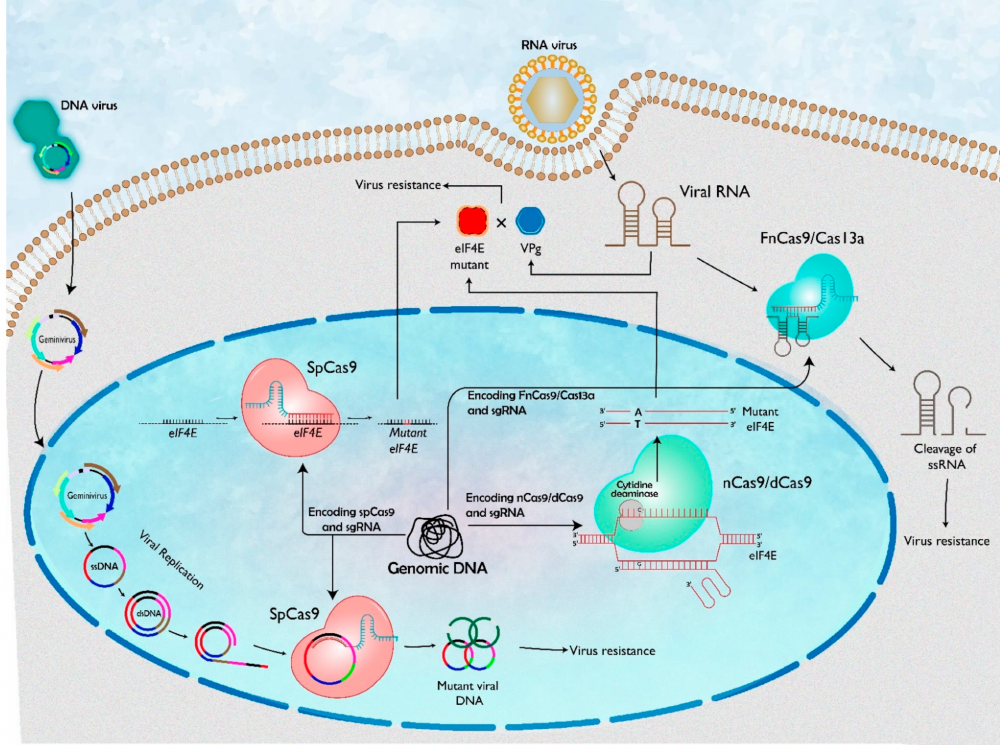
Figure 1. Representation of CRISPR/Cas systems to confer resistance against DNA and RNA virus. On entering plant cells, the viral genome is transcribed and translated using host factors. Subsequently, the viral genome is multiplied and spread to other cells. The viral genome can be targeted by the CRISPR system using Cas9/nCas9/dCas9/FnCas9/Cas13a as endonuclease. Components of the CRISPR/Cas9 machinery, sgRNA and Cas9 are expressed from the plant genome and form sgRNA- Cas9 complex. Upon viral infection, the viral DNA replicates through the dsDNA replicative form inside the nucleus of the host cell. The sgRNA-Cas9 complex targets the viral dsDNA and cleaves or mutates the viral genome. Similarly, viral RNA is targeted by sgRNA-FnCas9/Cas13a generating mutation in RNA. Potyviruses recruit host cellular translation factor eIF4E to translate their viral RNA and facilitate their infection. Thus, eukaryotic translation initiation factors eIF4E can be used as a target for CRISPR/Cas9, resulting in a recessive gene mutant form. This mutant form of eIF4E is not able to interact with VPg, a viral translation machinery protein. Furthermore, nuclease-defective Cas (dCas9/nCas9) employs base editing to impair viral RNA. This system contains a fused cytidine deaminase and a fused uracil glycosylase inhibitor